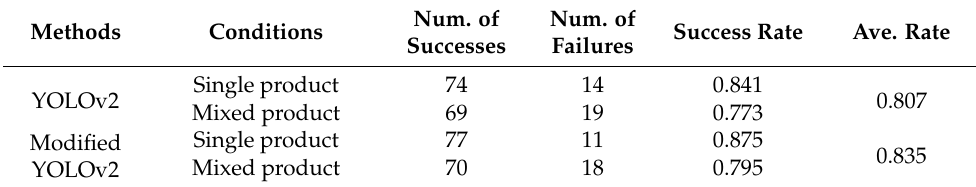
Table 4. The modified YOLOv2 test